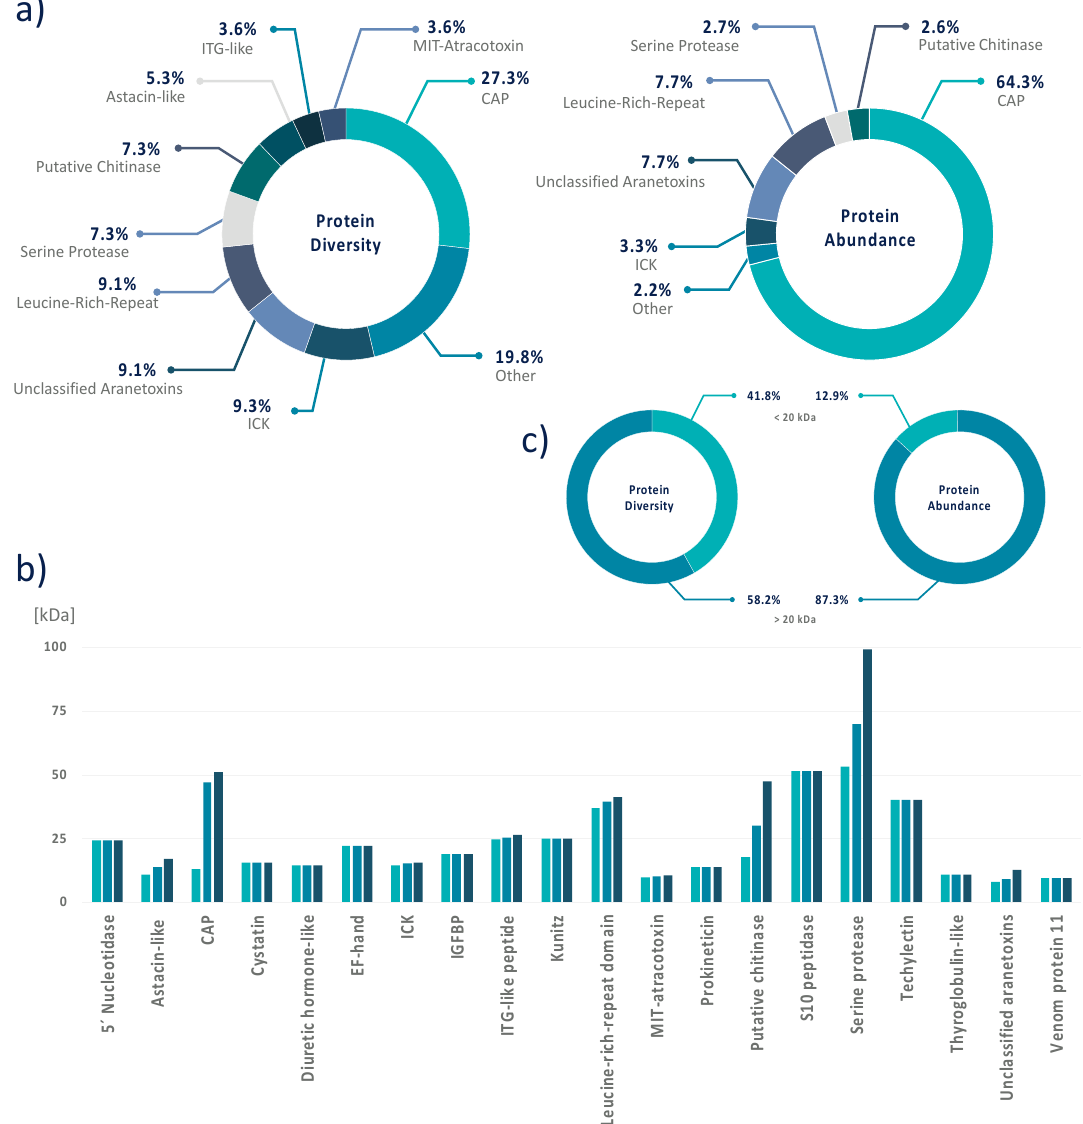
Figure 4. The venom protein profile of A. bruennichi . ( a ) Pie charts depict the venom composition in terms of protein diversity based on the number of distinct predicted coding sequences compared to protein abundance based on the transcripts per million reads for each coding sequence. By both measures, CAP family proteins are the dominant venom component, with 15 different members, many expressed at high levels. ( b ) The molecular weight (kDa) of identified venom proteins, with the lowest, average and highest molecular weights per group from left to right. ( c ) The distribution of small ( < 20 kDa) and large ( > 20 kDa) proteins in terms of protein diversity and protein abundance (TPM).